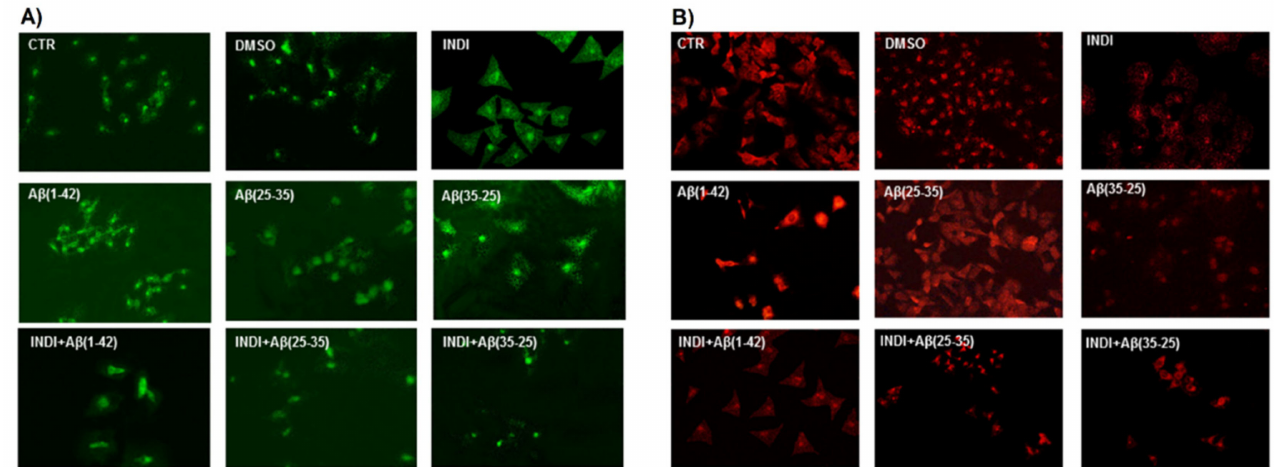
Figure 4. Staining of total intracellular reactive oxygen species (ROS) levels and O 2 − . Total intracellular ROS levels ( A ) and O 2 − ( B ) generation in OECs in different conditions: control, DMSO, 100 µ M indicaxanthin (INDI), 10 µ M A β (1-42) or A β (25-35 ) or A β (35-25) both in the absence and presence of 100 µ M INDI for 24 h. Scale bar 20 µ